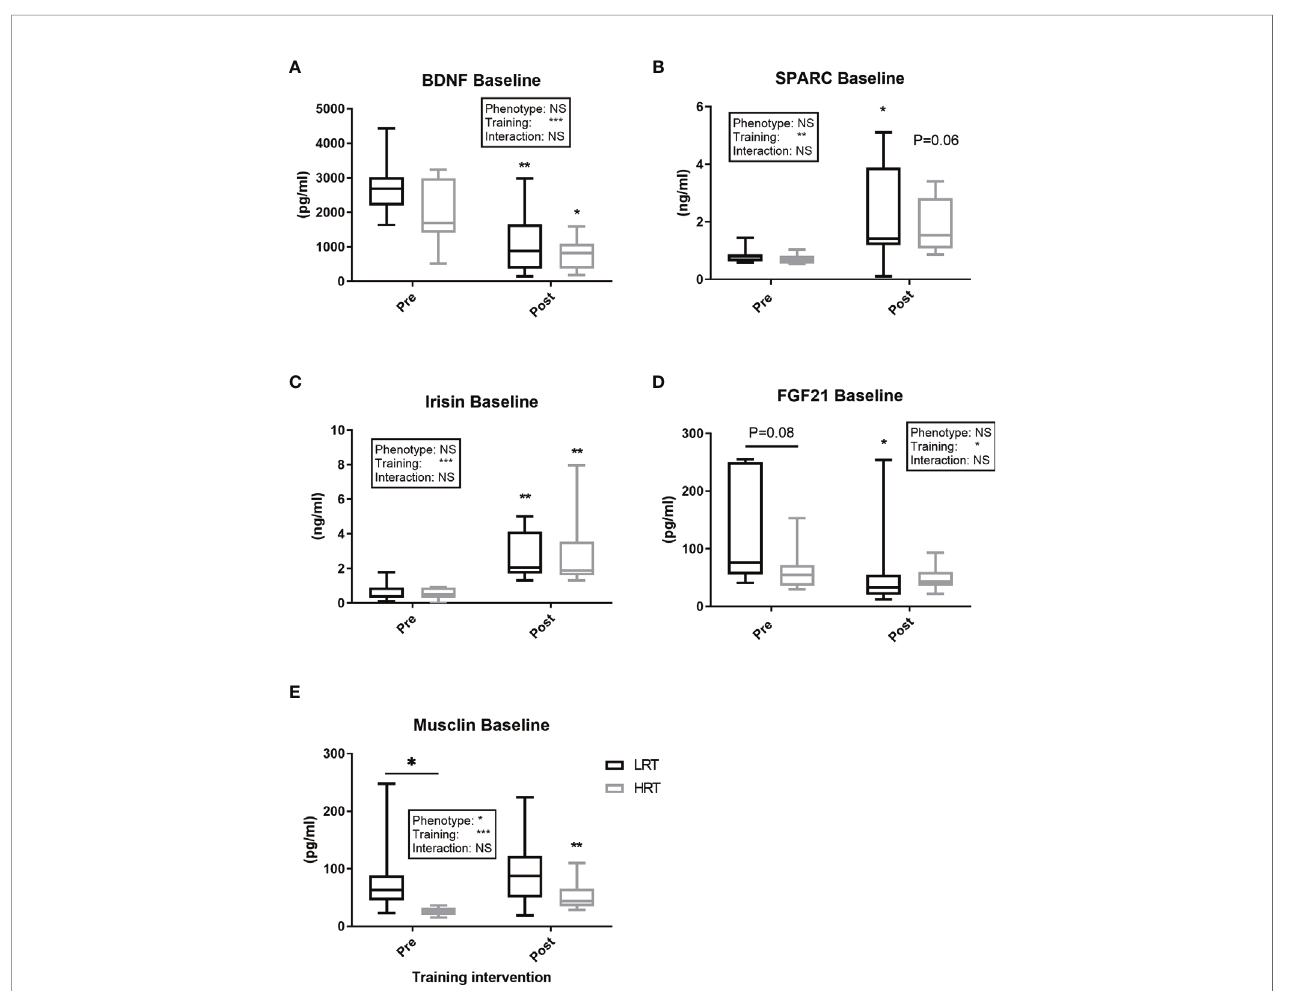
FIGURE 3 | Baseline concentrations of plasma myokines pre and post exercise training. (A) Brain-derived neutrophic factor (BDNF); (B) Secreted protein acidic and rich in cysteine (SPARC); (C) Irisin; (D) Fibroblast growth factor 21 (FGF21); (E) Musclin. Values are means±SD. Analysis via two-way ANOVA with Sidak ’ s post hoc test. Main effects are shown in the text box. *P<0.05, **P<0.01, ***P<0.001, NS, Not Signi fi cant. Non-underlined symbols represent within group differences. Underlined symbols represent between group